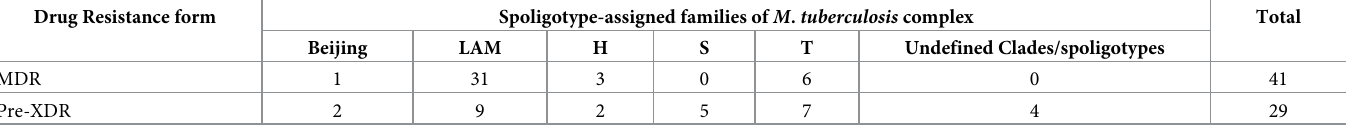
Table 2. Distribution of clades according to drug resistance status.